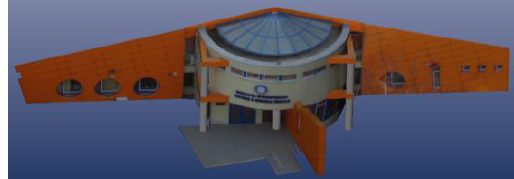
Figure 7. The „Dean’s office” front facade modelled in